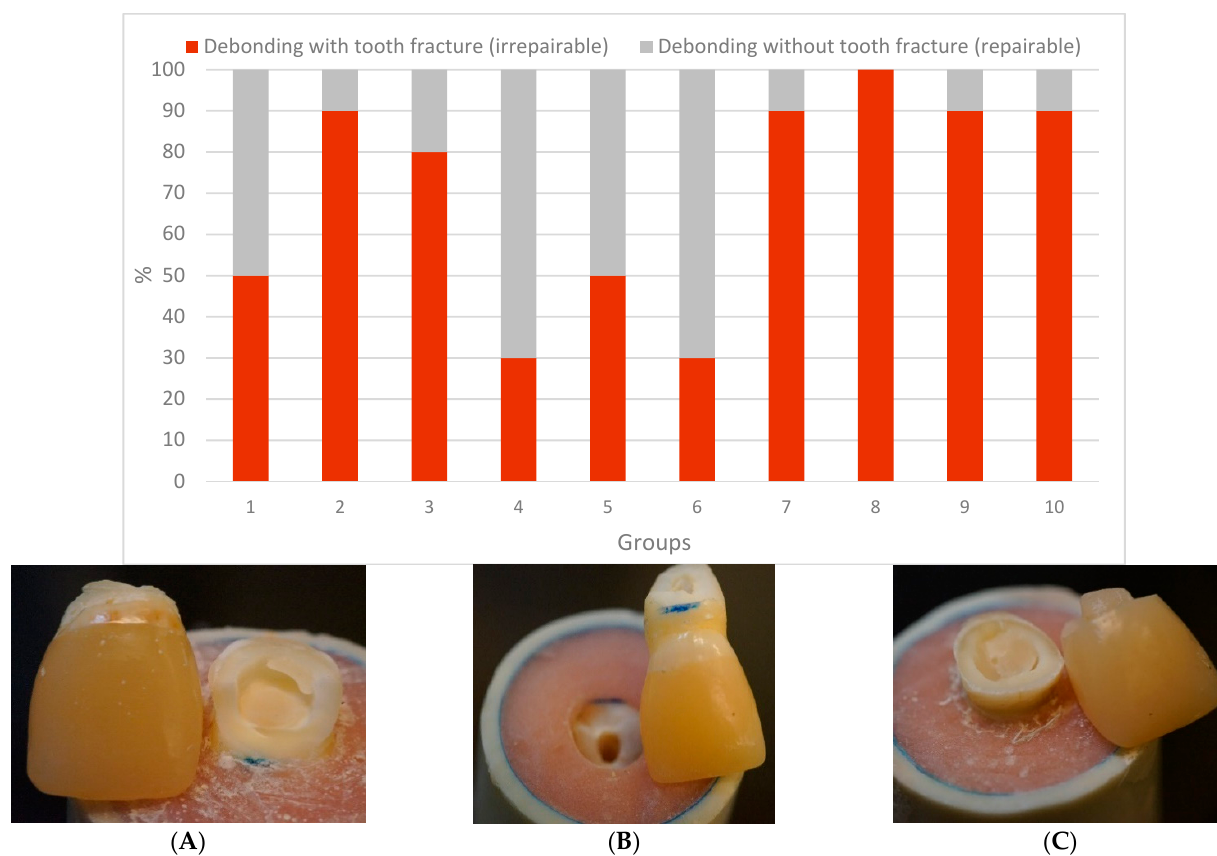
Figure 4. Percentages and photographs of failure modes of the tested restorations. ( A , B ): irrepairable fracture type, ( C ): repairable fracture type.